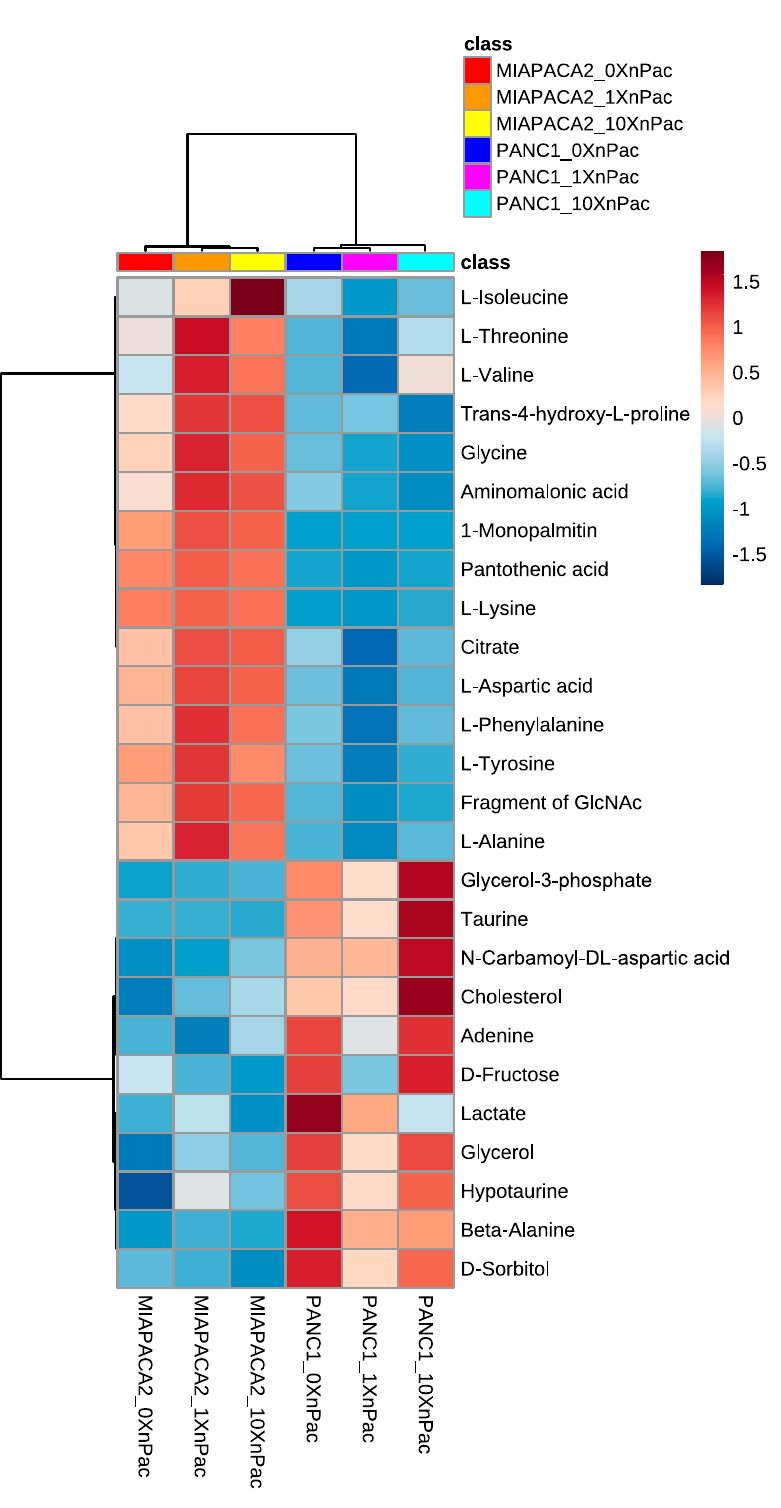
Figure 2. Heat map of metabolic, GC / MS-based profiling of PDAC cell lines upon treatment with chemotherapy. Significantly altered metabolites in MiaPaCa-2 and Panc-1 cell lines upon nab-paclitaxel treatment for 72 h. 0 × nPac: untreated control, 1 × nPac: IC50 concentration, 10 × nPac: ten-fold IC50 concentration. Range-scaled z-scores are shown. n = 3.